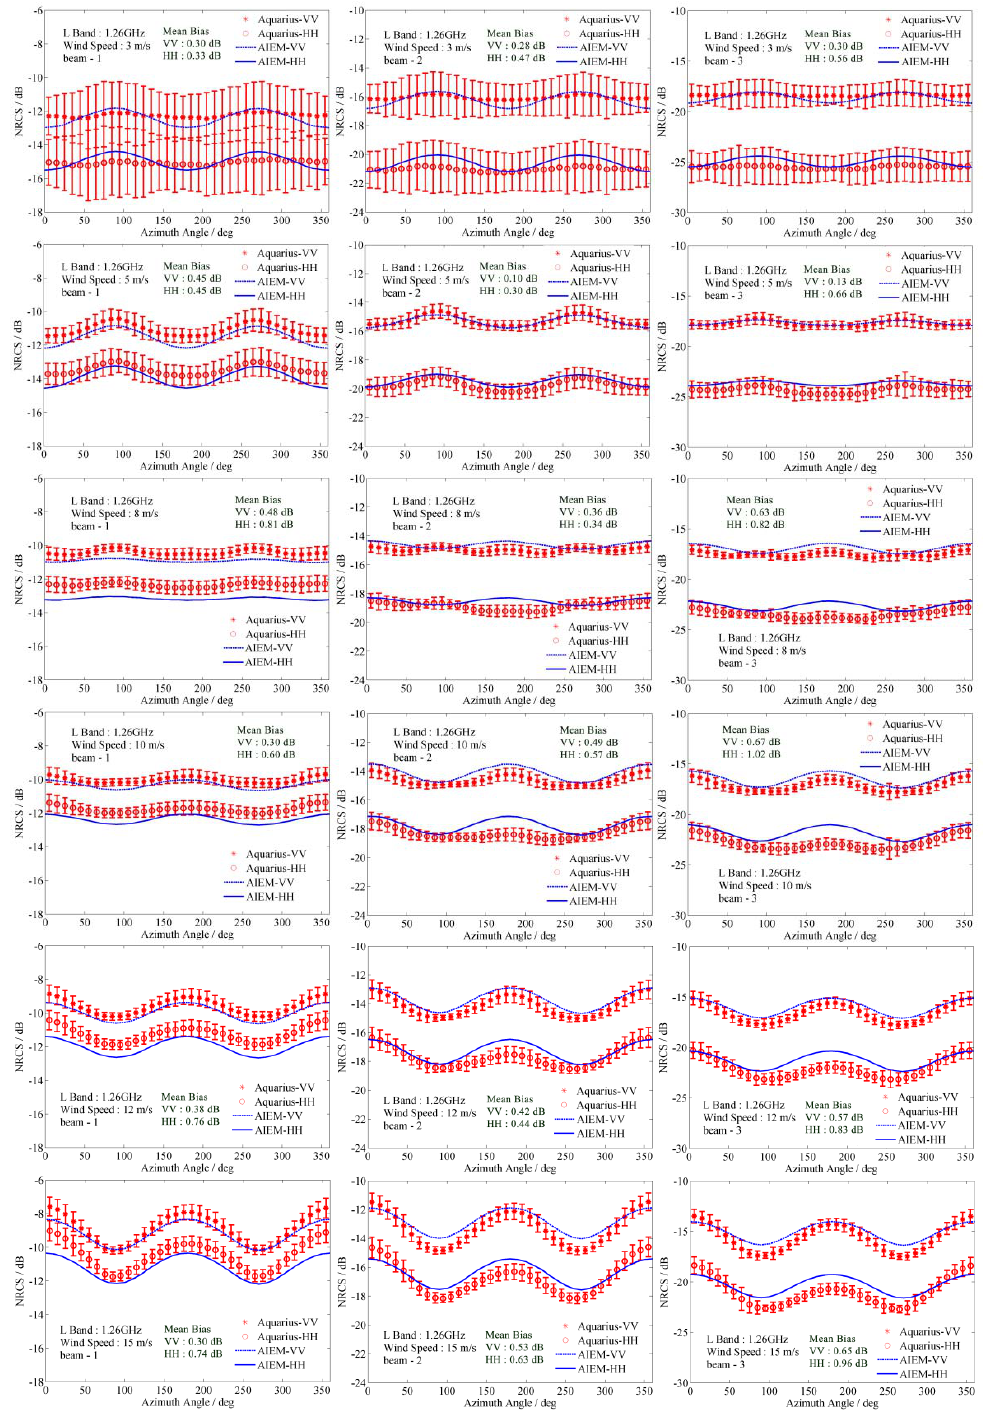
Figure 4. Comparison of normalized radar backscattering cross-sections (NRCSs) from model simulations and satellite observations versus relative wind direction. Each row represents a different wind speed; i.e., 3, 5, 8, 10, 12, 15 m/s. In each wind speed panel, the left column corresponds to beam 1, the middle column corresponds to beam 2, and the right column corresponds to beam 3. Here, beams 1, 2 and 3 denote the incidence angles of 28.7 ◦ , 37.8 ◦ and 45.6 ◦ , respectively. Red stars and circles are the binned matchup averages for VV and HH polarization, respectively; the vertical bars represent ± 1 SD of the matchup data. Blue dashed lines and solid lines are model simulations for VV and HH polarization,